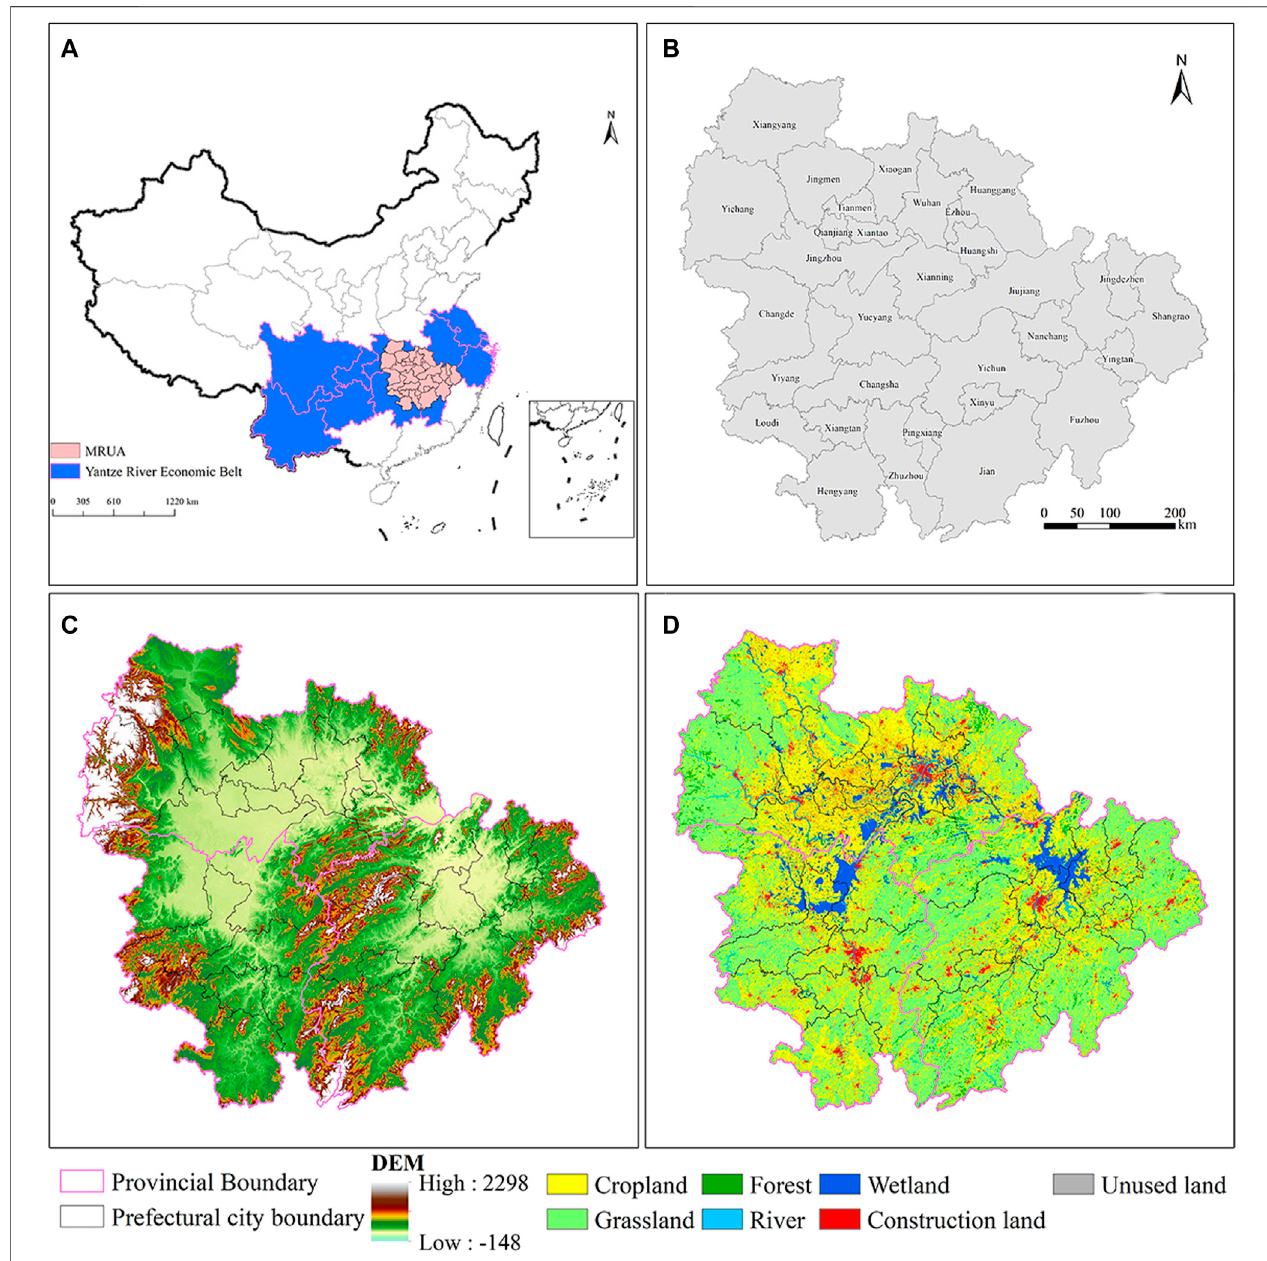
FIGURE 1 | Location (A) , names of prefectural cities (B) , DEM (C) , and land use in 2020 (D) of MRUA.